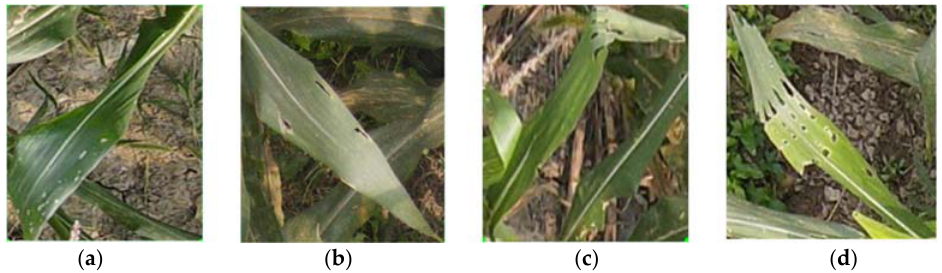
Figure 2. Classification examples of severity degree of corn leaves fed on by S. frugiperda : ( a ) juvenile; ( b ) minor; ( c ) moderate; and ( d ) severe feeding.